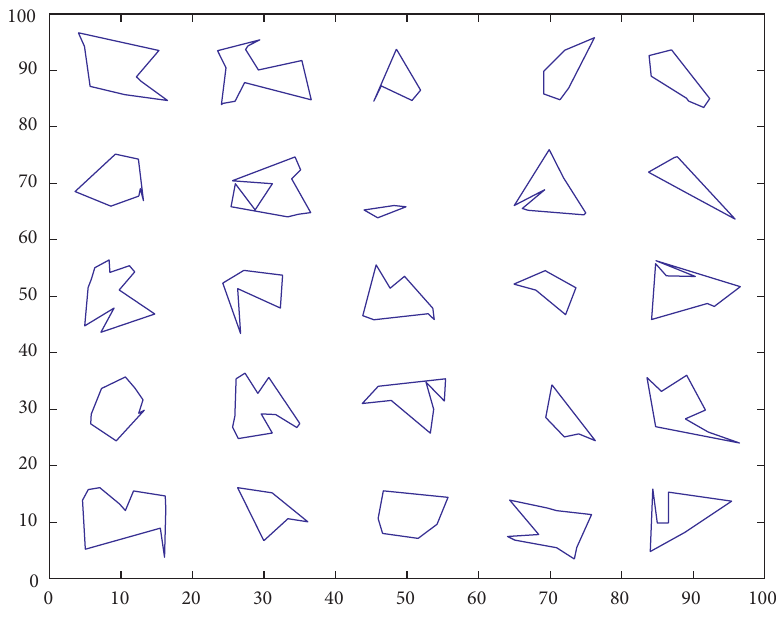
Figure 1: Schematic diagram of complex occlusion